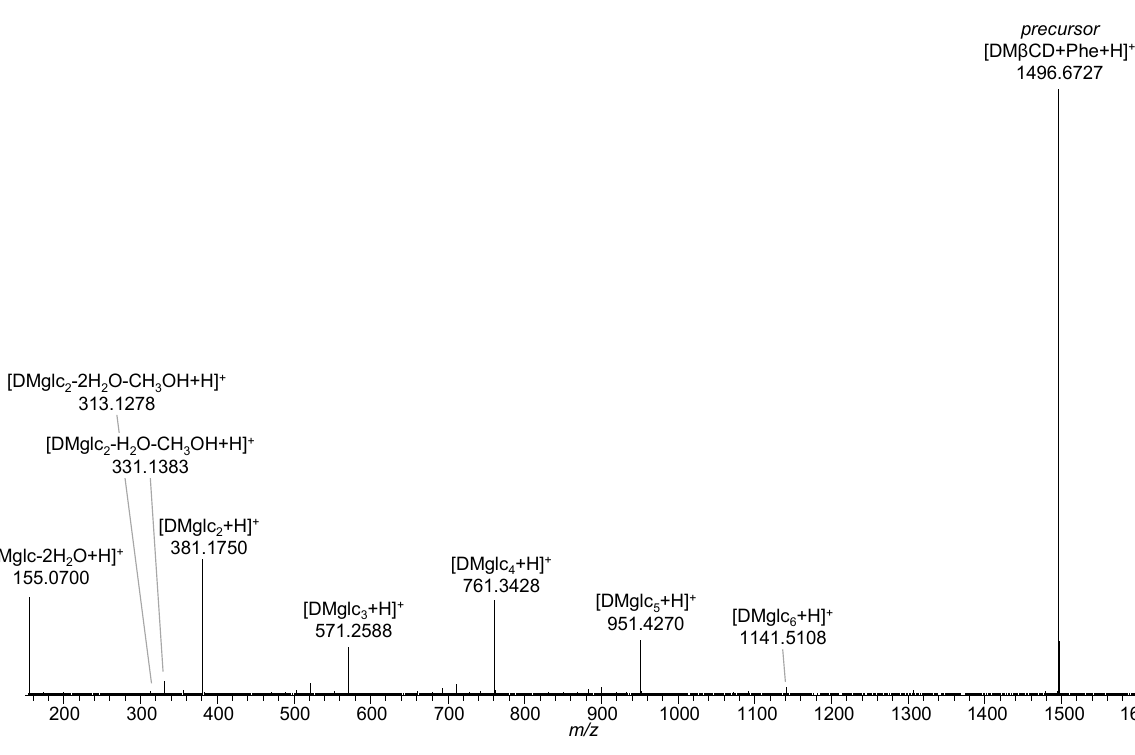
Figure 6. HCD mass spectrum of [DM β CD + Phe + H] + ( m / z 1496.70) at 40 eV (15% NCE) showing the separation of the precursor ion and subsequent decomposition of DM β -cyclodextrin into its subunits [DMglc n + H] + .